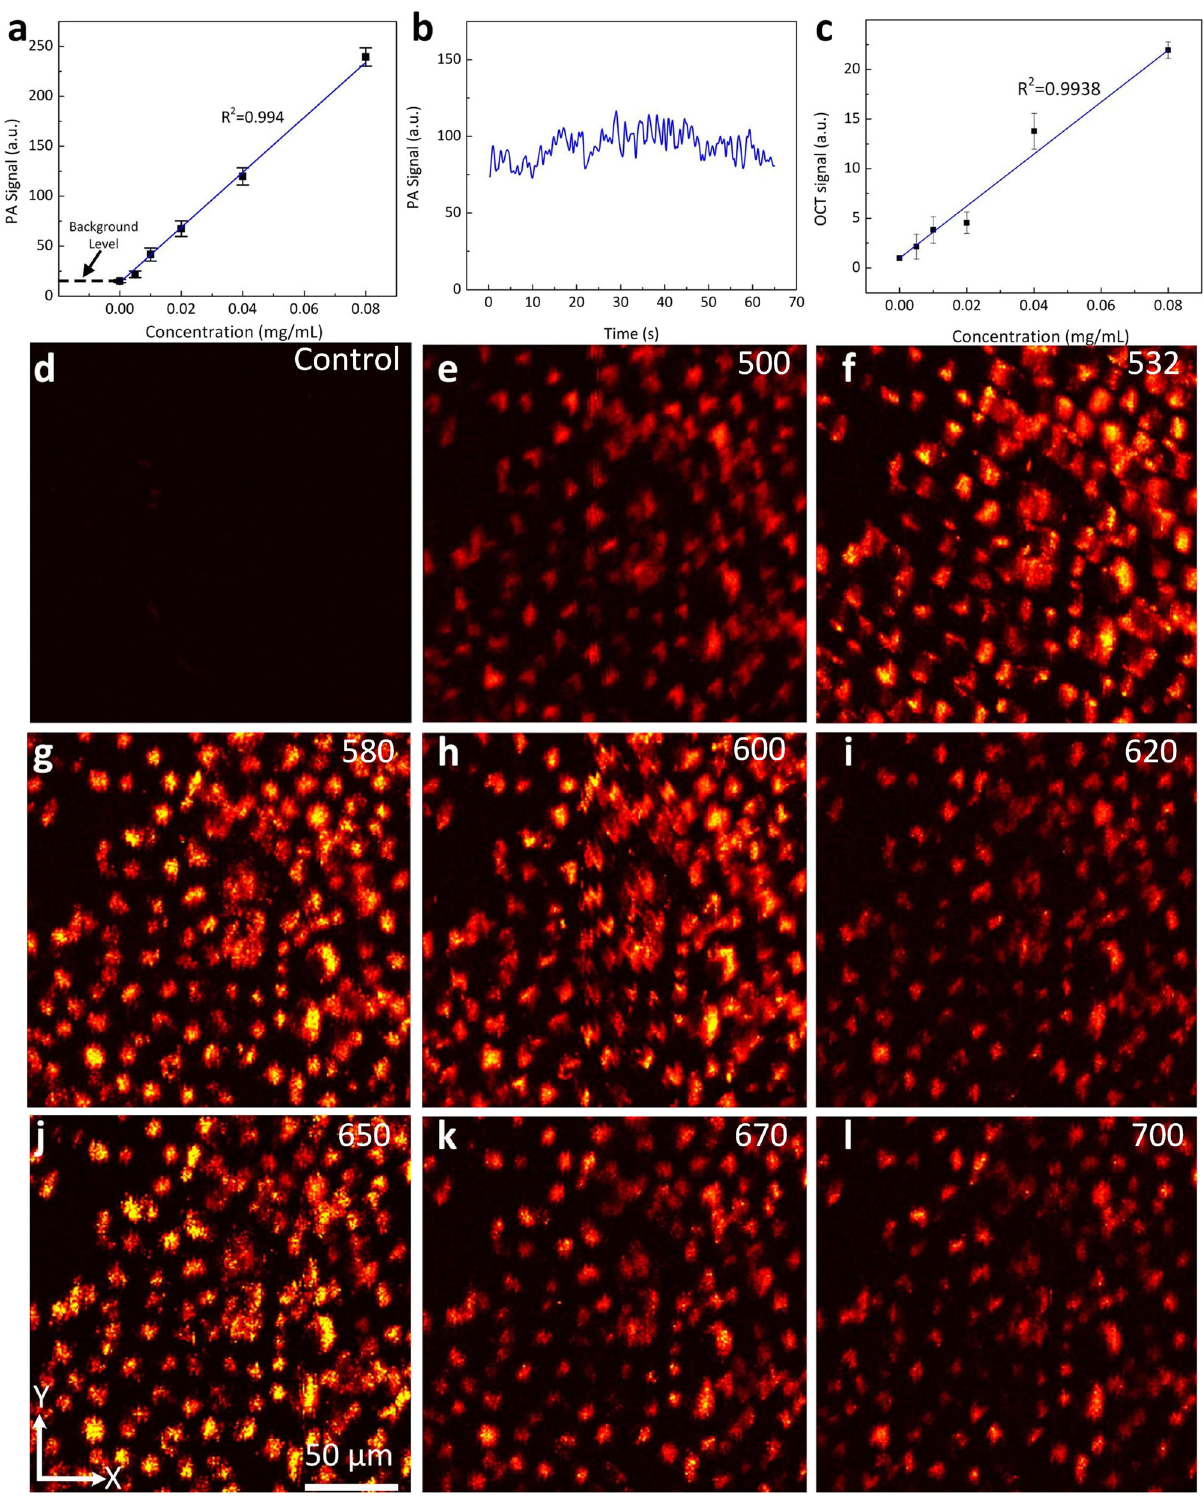
Fig. 2 Quanti fi cation of the photoacoustic (PA) and optical coherence tomography (OCT) properties. a Quantitative PA signal of the CGNP clusters- RGD in phantom as a function of nanoparticle mass concentration and estimating the average PA amplitude above the background level in each image. ( b ) PA signal from CGNP clusters-RGD in phantom as a function of laser irradiation time. c Quanti fi cation of OCT signal from CGNP clusters-RGD of different concentrations in phantom. d – l ) In vitro PAM images of cells acquired at various wavelengths ranging from 500 to 710 nm. The error bars in a and c represent the standard deviation of the mean PA signal measured from 3 different samples ( N = 3). Source data are provided as a Source Data fi